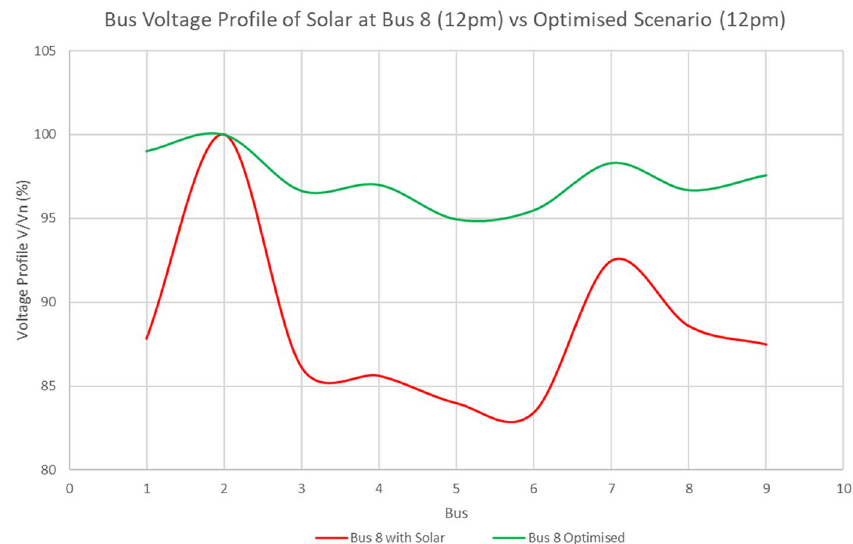
Fig. 9 Bus voltage profile improvement to its optimised